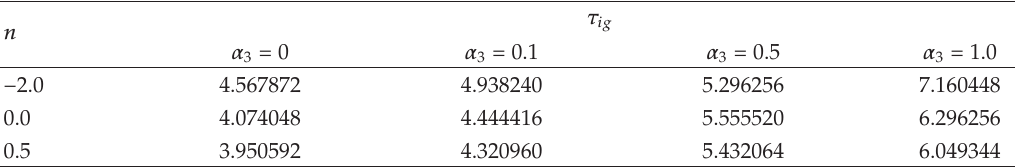
Figure 5: Variation of θ g , θ s , r , and η with numeric exponent for various values of α 3 at ignition point. Table 1: Variation of ignition times with interphase heat exchange parameter at ignition point when n (cid:7) {− 2 , 0 , 0 . 5 }